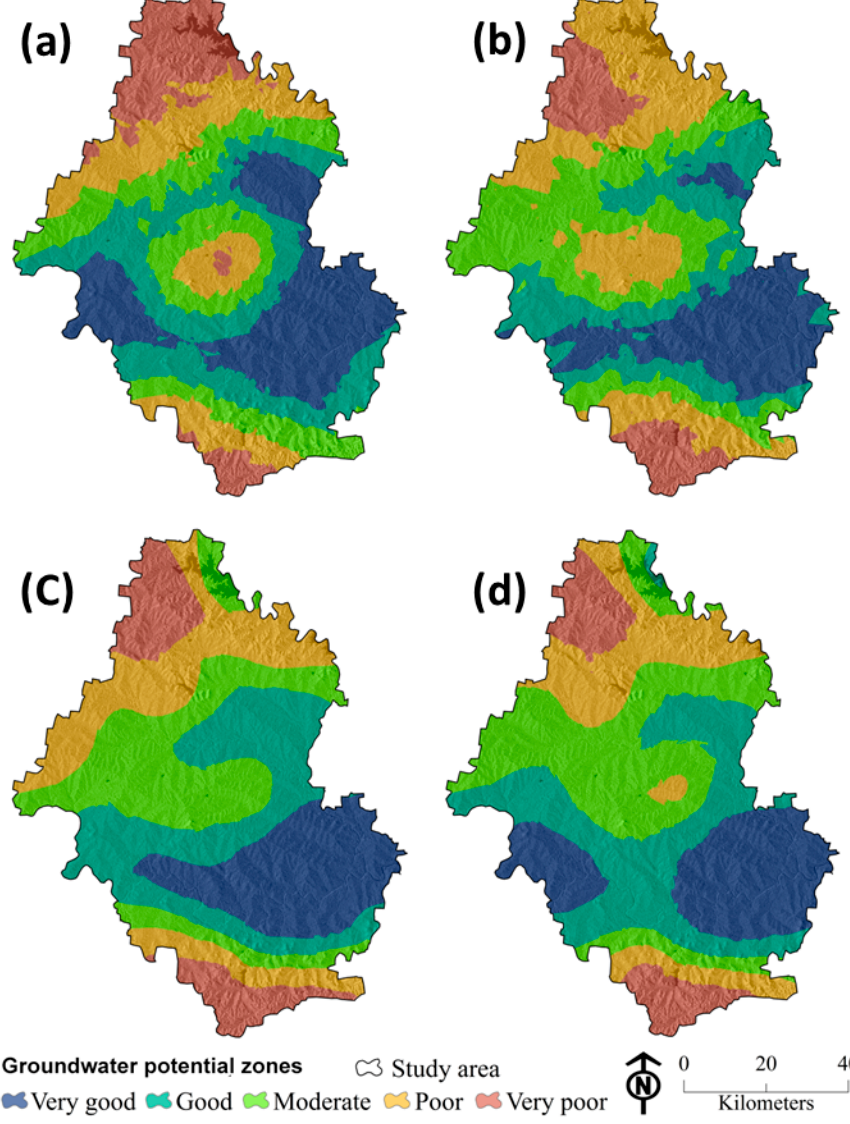
Figure 5. Groundwater potential zones: ( a ) ANN-MLP ( b ) RF ( c ) SMOReg ( d ) M5P.